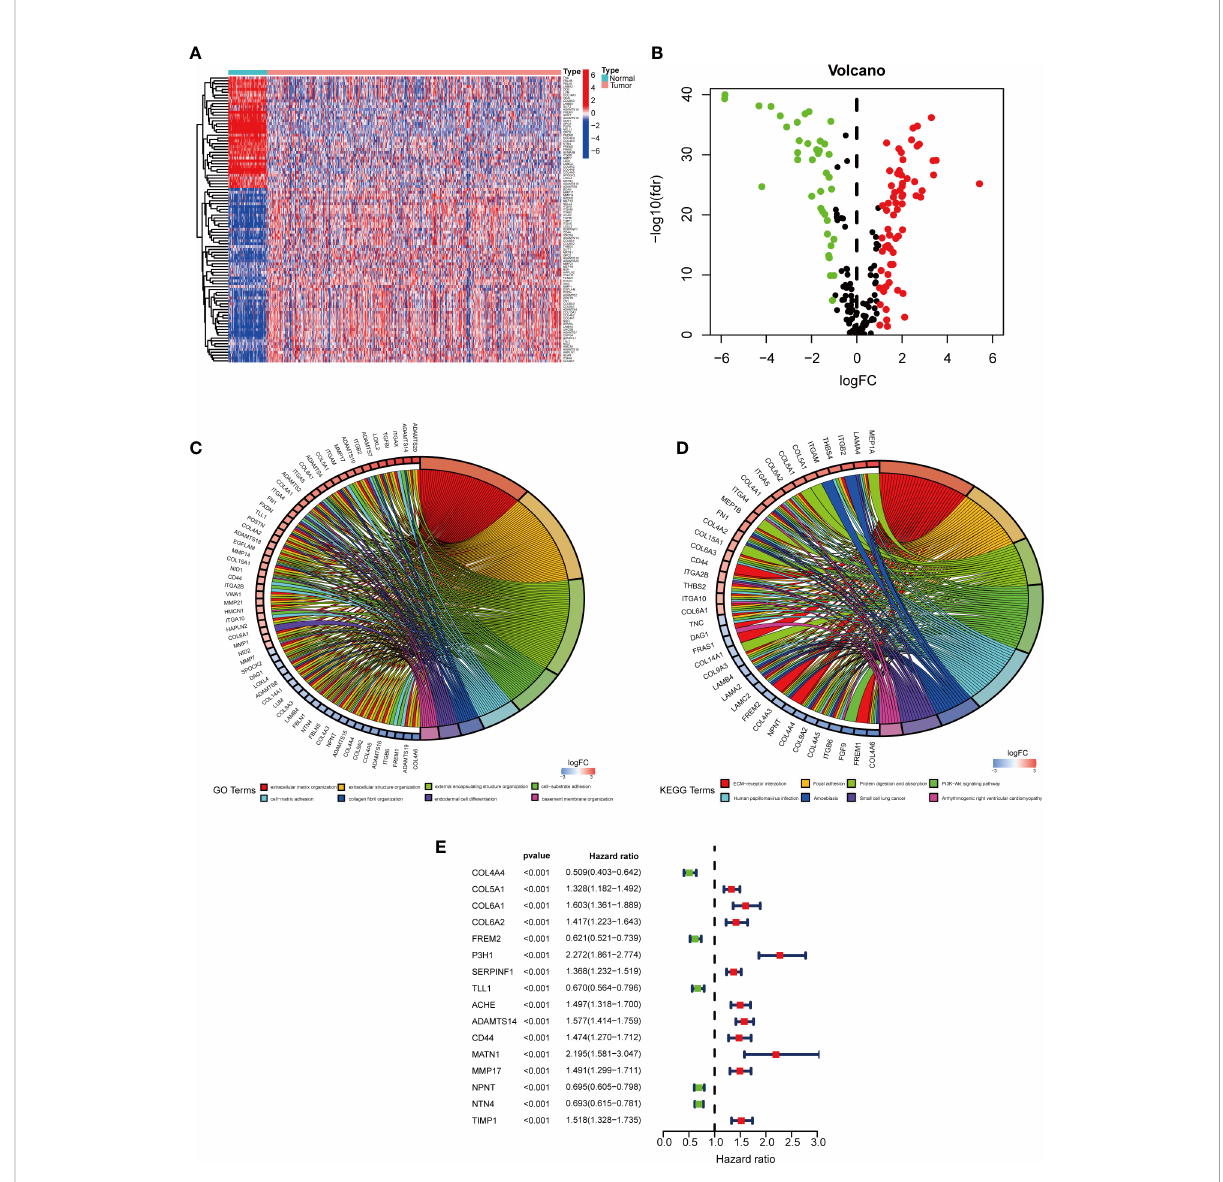
FIGURE 2 Differentially expressed BMGs in KIRC cases. (A) Enrichment plot of 106 BMGs in normal and tumor tissues. (B) The volcano plot of 106 differentially expressed BMGs with differential expression. (C, D) . Noticeable enrichment of GO terms and KEGG pathways of 106 BMGs. (E) The forest plot illustrated a uni-Cox-reg analysis of the association of 16 BMGs with